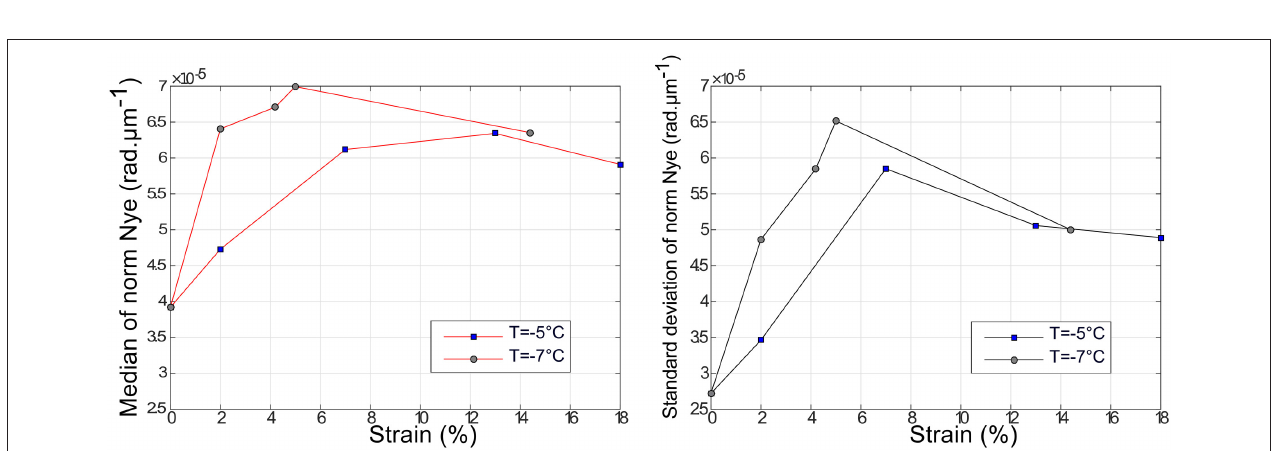
FIGURE 9 | Map of the norm of the Nye tensor (rad. µ m − 1 ) after 2, 7, and 13% strain, at − 5 ◦ C, as obtained from the 50 µ m resolution EBSD data.